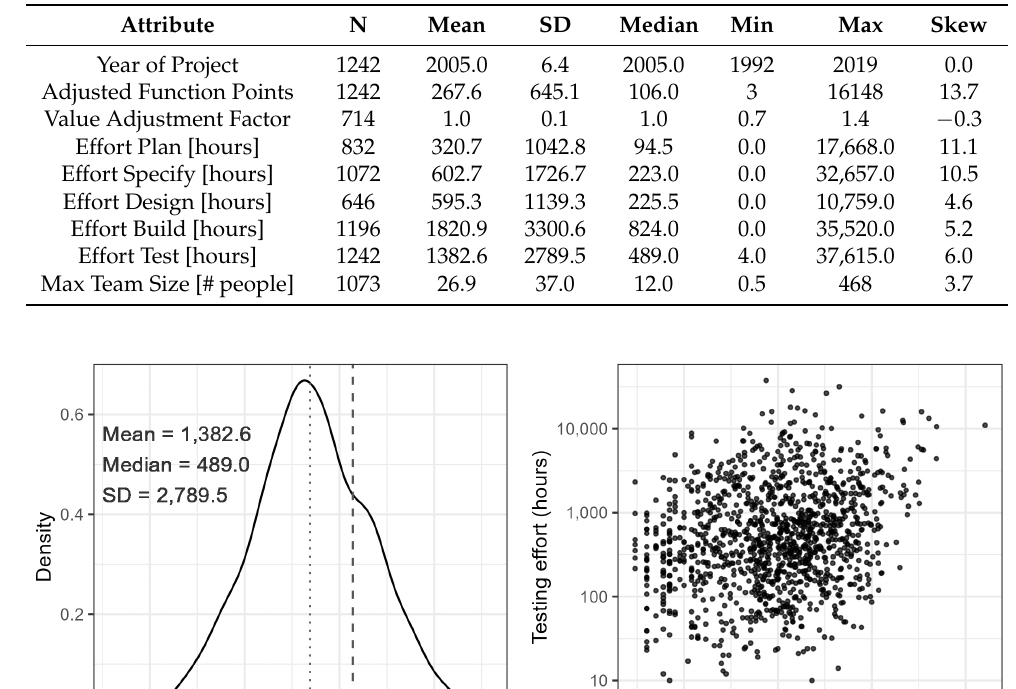
Table 1. Summary statistics for numeric variables.